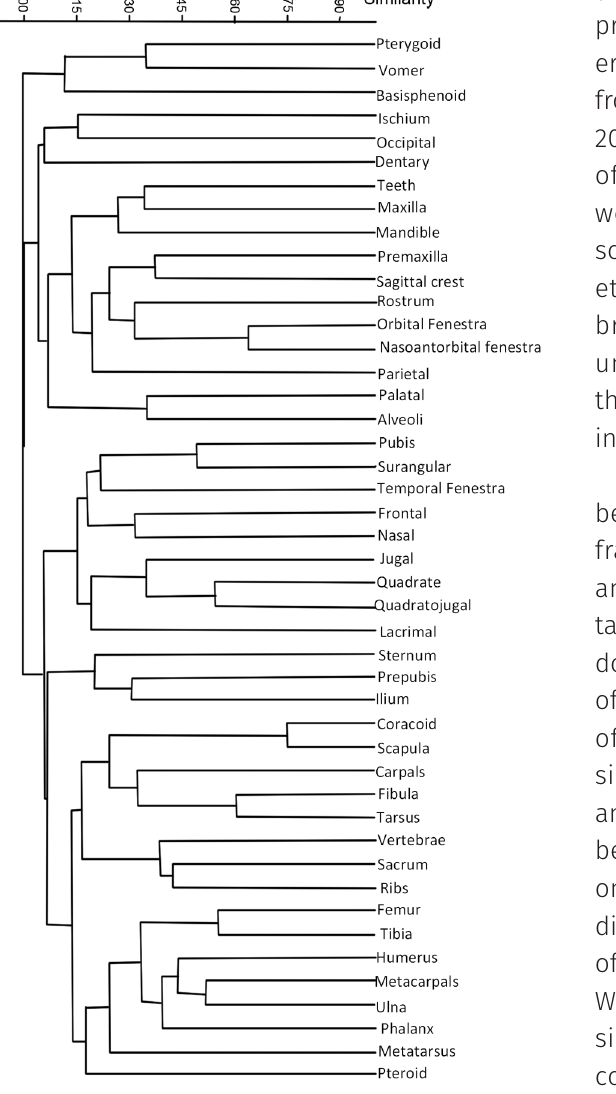
Figure 7. Dendrogram showing the co-occurrence of diagnostic